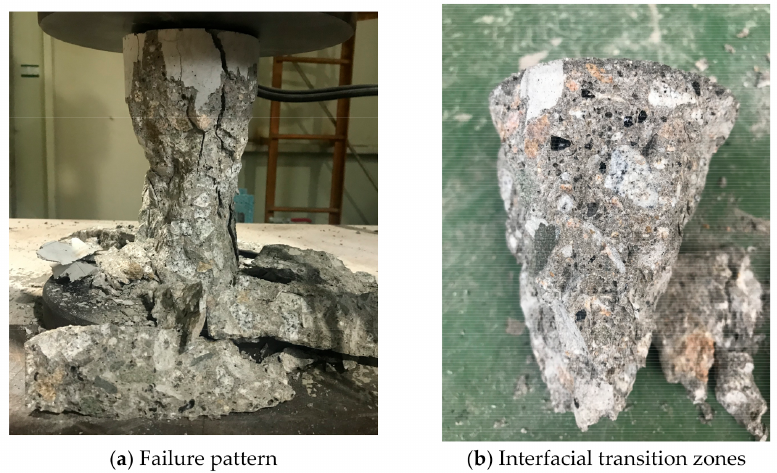
Figure 6. Typical compressive failure pattern of the CBA